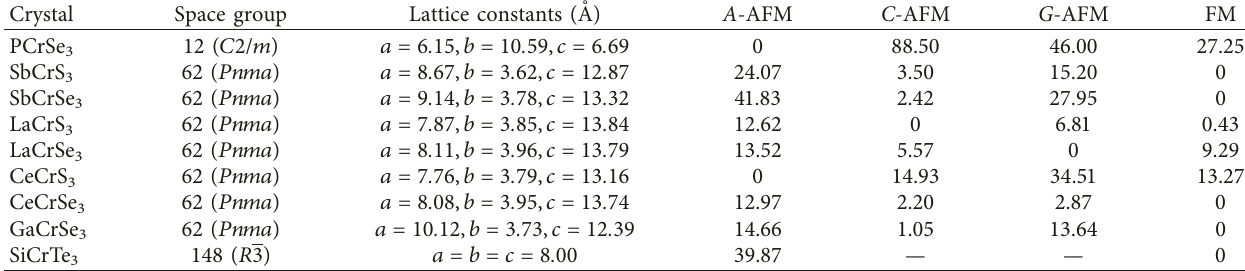
Table 1: Calculated energies (in meV per formula unit) of different magnetic states of the chromium chalcogenides. The energy of the lowest state for each material is set to zero for ease of comparison. For PCrSe 3 , α � c � 90 ∘ and β � 107 . 71 ∘ . For SiCrTe 3 , α � β � c � 50 . 56 ∘ . For SiCrTe 3 , each unit cell contains two Cr atoms; hence, there is only one possible antiferromagnetic state. Crystal